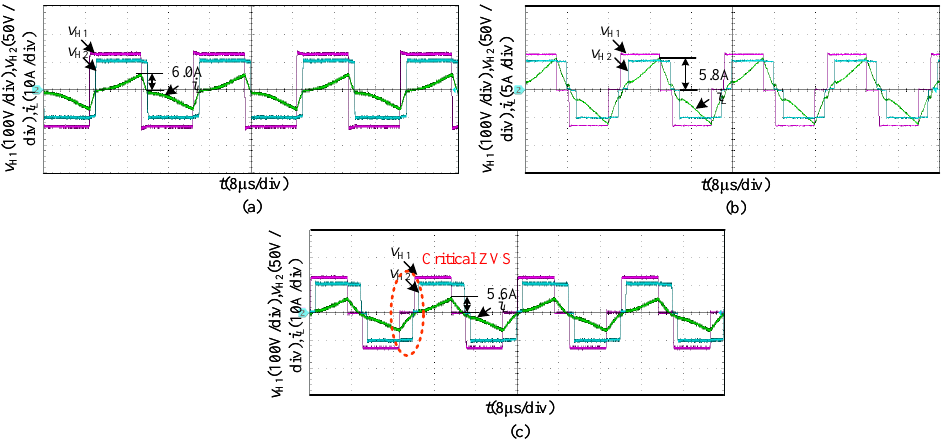
Figure 8. Steady-state waveforms of different control strategies under light load: ( a ) the SPS control strategy, ( b ) the current-stress optimization control strategy of DPS control, ( c ) the MUOC